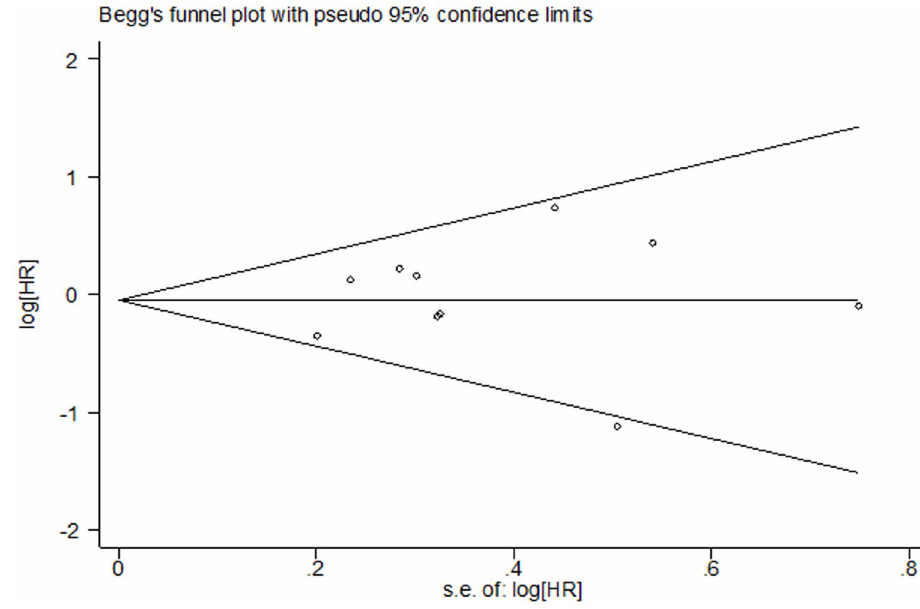
Figure 5. Funnel plot for publication bias test DFS. The two oblique lines indicate the pseudo 95% CI.